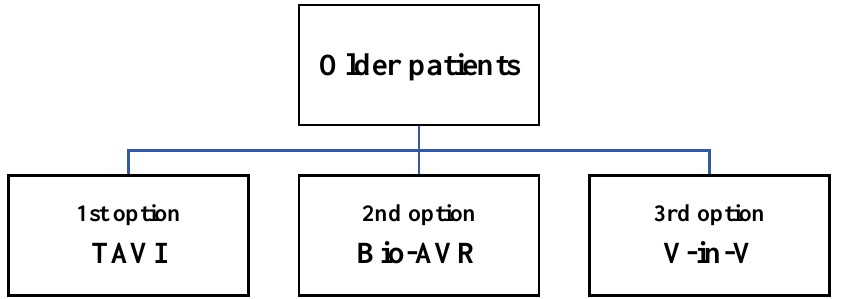
Figure 3. Priority of aortic valve substitutes for older patients.